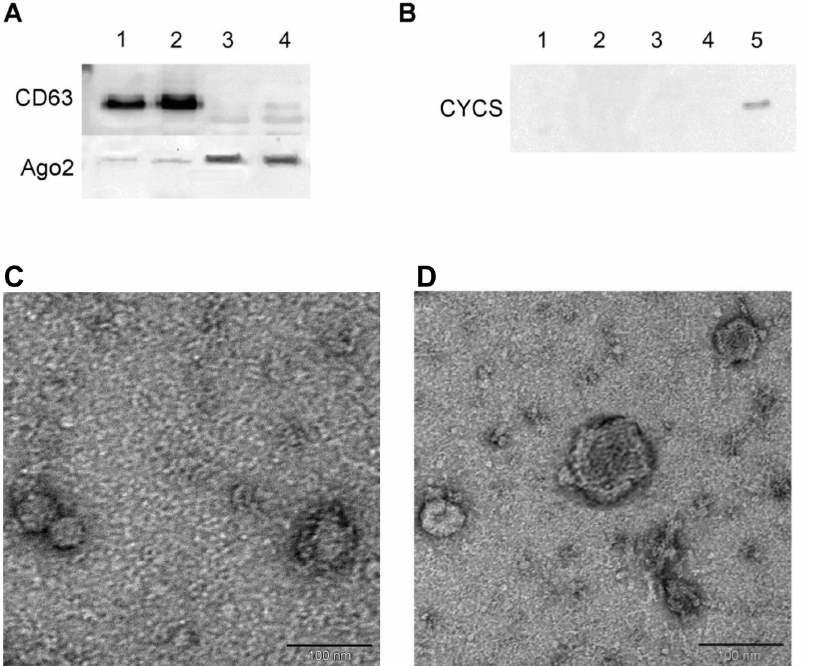
Figure 1. Western blot analysis (A & B) of exosomal and non-exosomal fractions of follicular fluid and morphological presentation of exosomes using electron microscopy (C & D). (A) Proteins (50 m g) from exosomal fraction (lane 1 & 2) and non-exosomal fraction (lane 3 & 4) of follicular fluid isolated either by ultracentrifugation (lane 1 & 3) or Exoquick kit (lane 2 & 4) were resolved on a 12% SDS-PAGE gel to detect CD63 and Ago2 proteins. (B) Confirmation of absence of detection of CYCS (mitochondrial protein) in both exosomal and non-exosomal proteins as isolated by ultracentrifugation (lane 1 & 3) and Exoquick kit (lane 2 & 4). A known cellular origin protein was used as a positive control (lane 5). Morphological characterization of exosomes isolated from bovine follicular fluid using Exoquick kit (C) and ultracentrifugation (D) by transmission